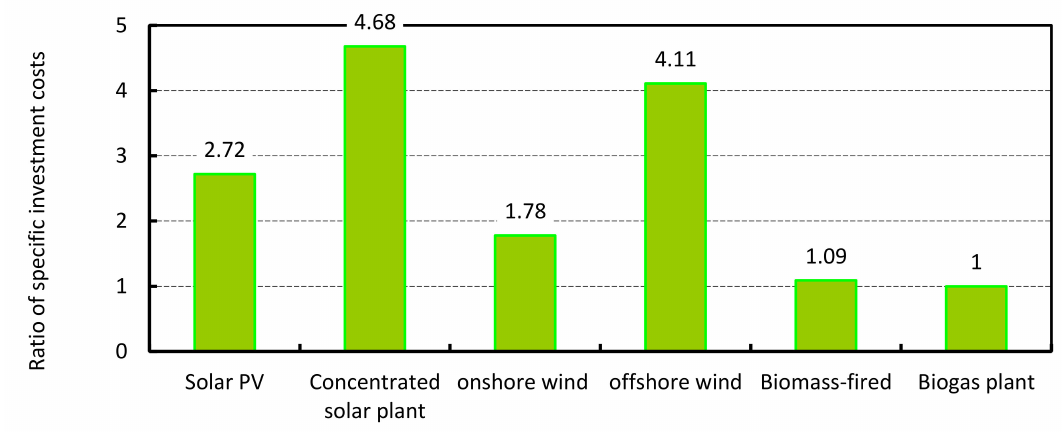
Figure 6. Ratios of adjusted specific investment costs.